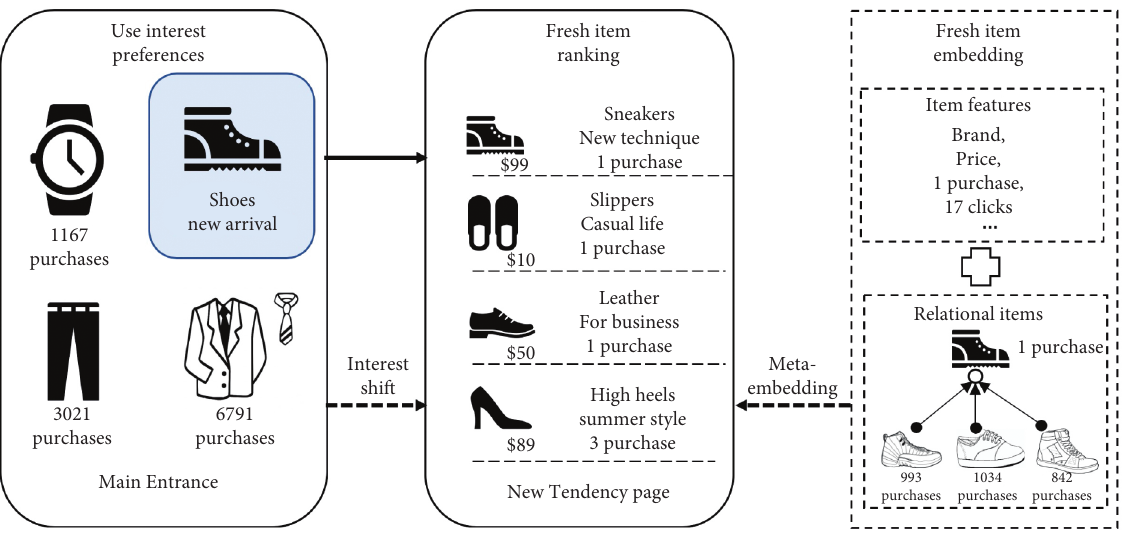
Figure 1: An illustration of fresh item recommended. Once a user clicks the card on the left side, a fresh-item recommendation page (middle side) appears to achieve interest shifting from users’ history interests to the fresh items, where the recommended fresh items are ranked using the embeddings of fresh items and relational items (right side). All the fresh items on the recommended page are chosen from a specific fresh item pool, which are usually less exposed than items on the main entrance